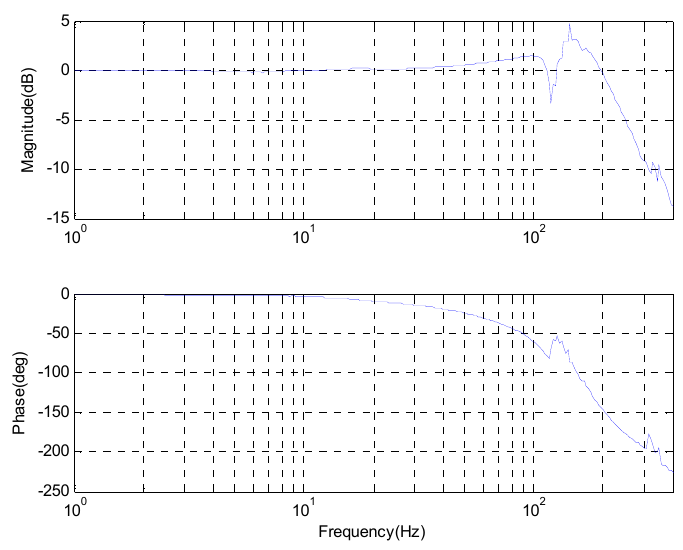
Figure 6. The Bode response of the control plant.